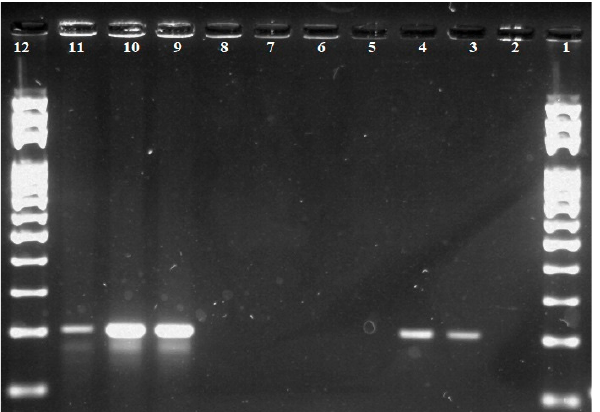
Figure 1. Comparison and verification of three isolation procedures for samples of wheat semi- coarse flour and dark wheat bread. Lane 1—100 bp standard; lane 2—negative control; lanes 3, 6, 9—semi-coarse wheat flour sample (PCR product = 200 bp); lanes 4, 7, 10—wheat bread sample